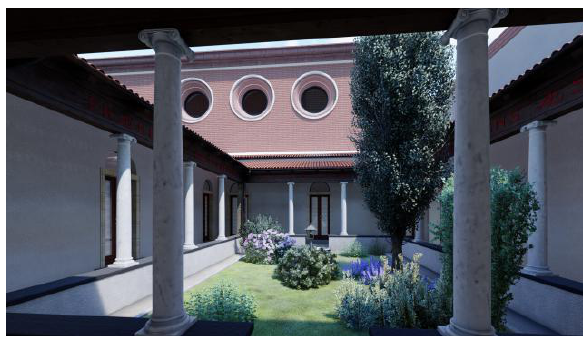
Figure 14. VR experience: The Cloister of the